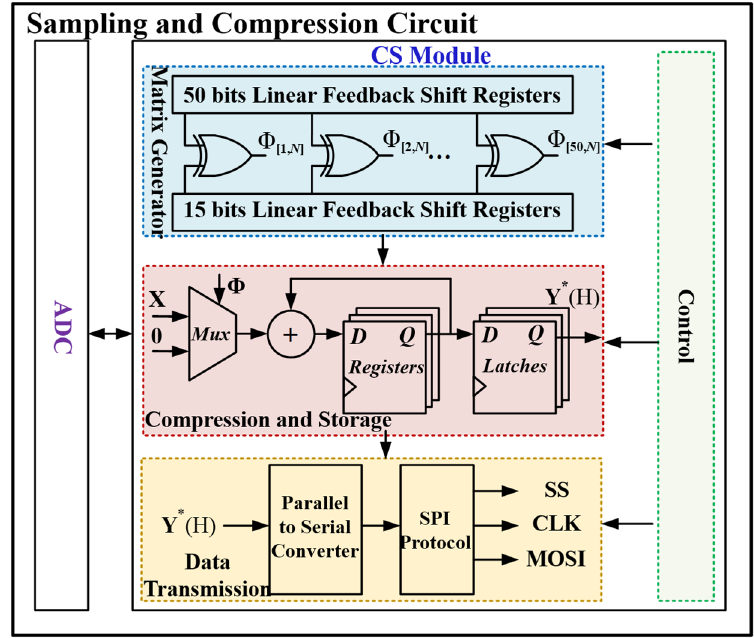
Figure 6. The structure of the sampling and compression